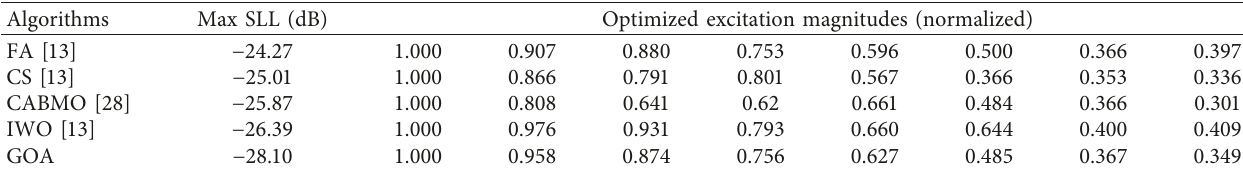
Figure 12: Array factor of 16-element linear array for example 4. Table 6: Excitation magnitudes of 16-element linear array after optimization.